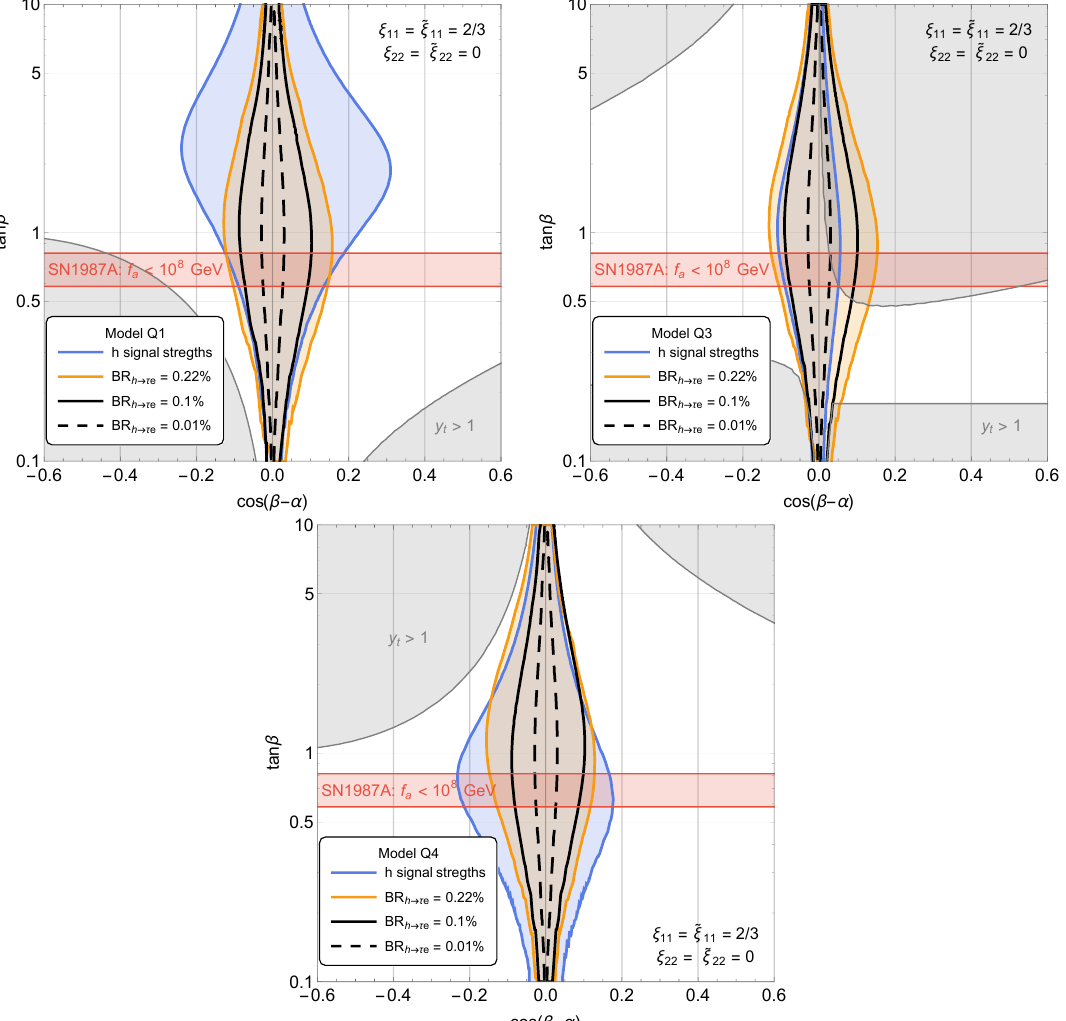
Figure 3 . Parameter space allowed by BR( h → τe ) (orange region) and Higgs signal strengths (blue region) for various quark models. The results for the Q2 model are the same as those for the Q3 model. We furthermore show the sensitivity for experiments that could prove branching ratios of 0 . 1% and 0 . 01% . The gray areas denotes regions where Higgs couplings y t > 1 , indicating the potential loss of perturbativity. Also shown is the region where the SN1987A constraint is satisfied for f a = 10 8 GeV